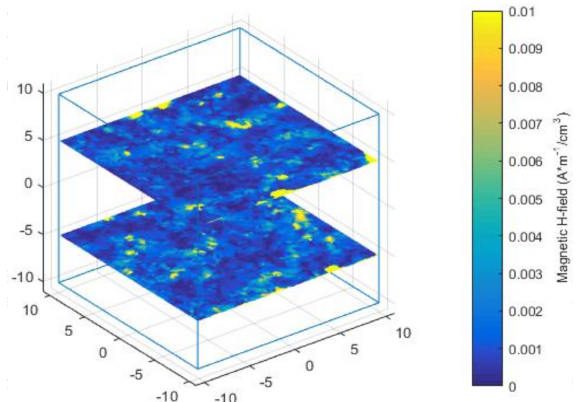
Figure 7. Chromatogram of the magnetic H-field when the volume fraction of ferrite grains is 50%.